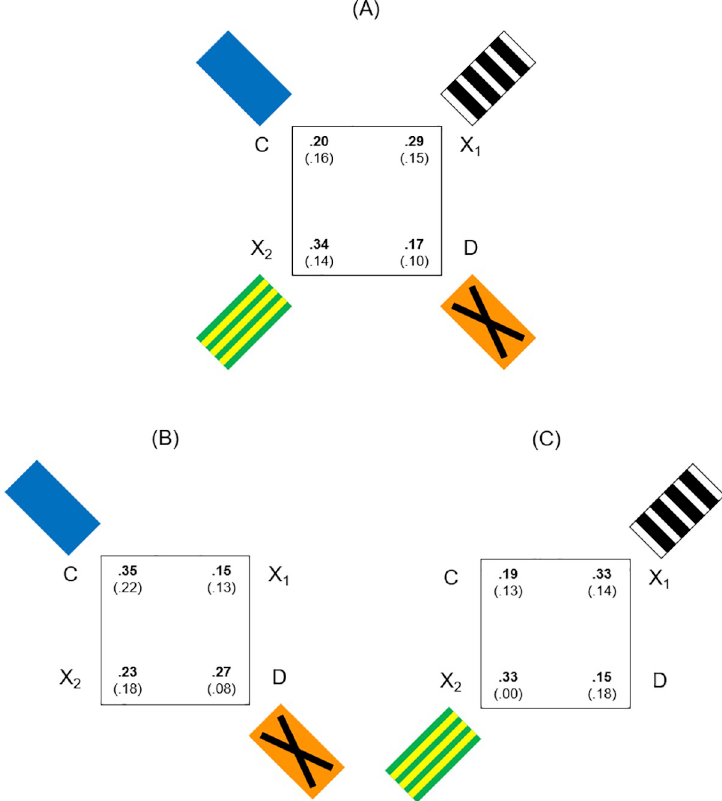
Fig 6. First approaches in Experiment 2: Square apparatus with panels in the spontaneous memory task. (A): Mean (SD) proportions of first approaches at the four corners, in the spontaneous cued memory task, in the experimental condition with four colored panels at corners in the square apparatus (only landmarks) ( Experiment 2 ). (B) and (C): Mean proportions of first approaches in the experimental conditions with two colored panels at corners C-D (landmark near the correct corner) and X1-X2 (landmark far from the correct corner) in the square apparatus.